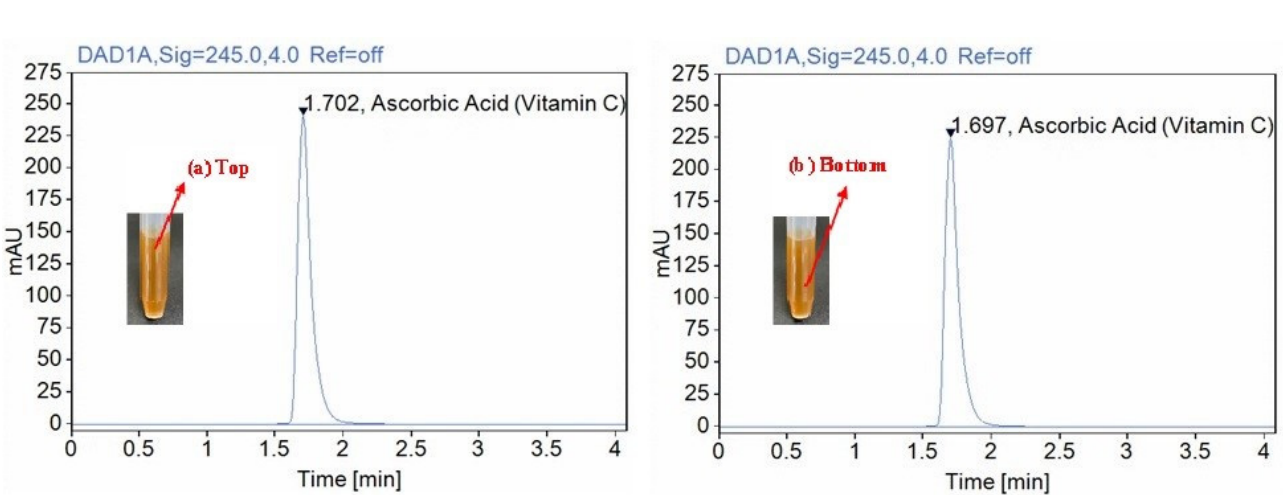
Figure 2. Representative liquid chromatograms obtained using UHPLC–DAD for liposomal vitamin C, sampled from the two separate sample regions shown in the inset: Top ( a ) and Bottom ( b ).